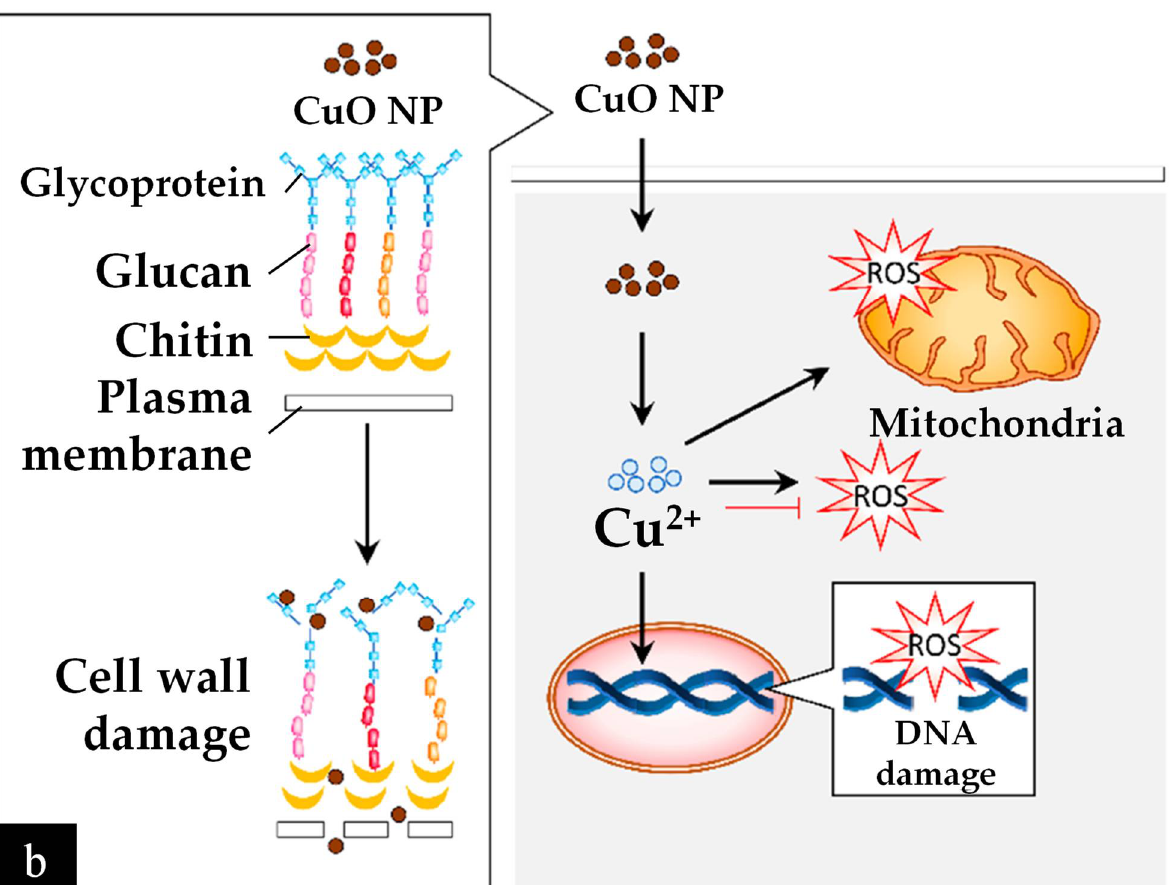
Figure 6. ( a ) Diagram of the respective mechanisms of CuO nanoparticle antibacterial activity in Gram-positive and Gram-negative bacteria and ( b ) diagram of the mechanism of CuO nanoparticle antifungal activity. Adapted with permission from Ref. [205]. 2020, MDPI.